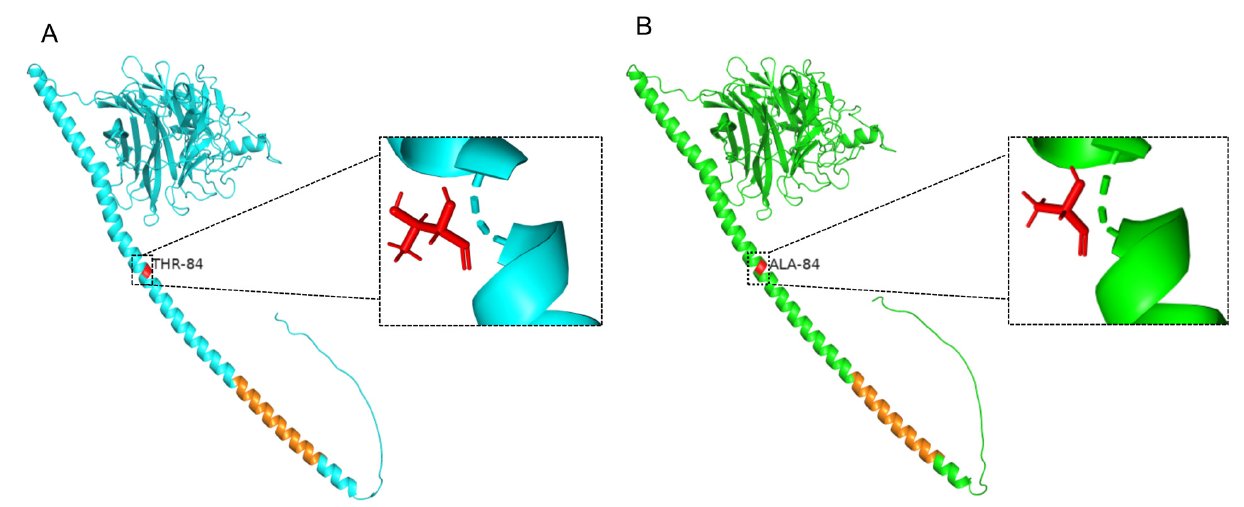
Figure 3. Structural model of HN protein. ( A ) The sequences from this study (GenBank number: OP908143). ( B ) Sequence as a reference (GenBank number: MH357343). Red bars represent mutation sites and orange bars represent transmembrane domains.